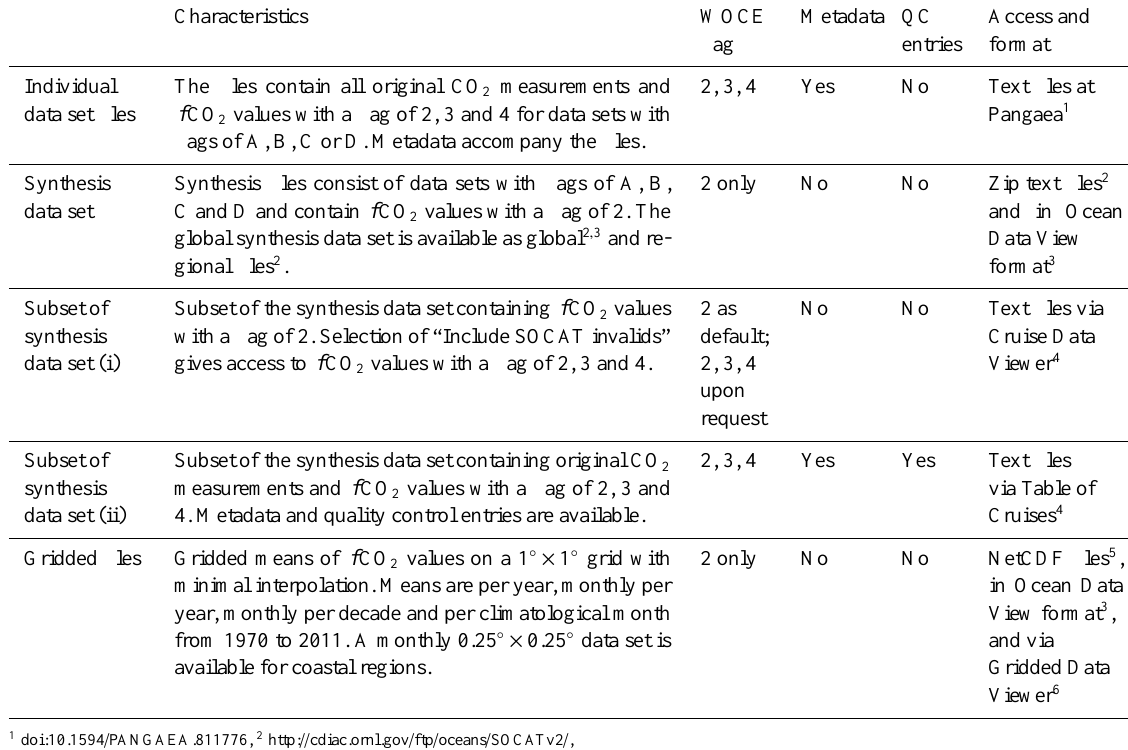
Table 2. Key characteristics of the three SOCAT data products for surface ocean f CO 2 values in version 2 (Sect. 2.4). The synthesis product is available as synthesis files and as subsets of the global synthesis data set. The table lists whether the data products include only f CO 2 data with a WOCE flag of 2 (good) or also with flags of 3 (questionable) and 4 (bad). Information on access to metadata and quality control comments is provided. All data products can be accessed via the SOCAT website (http: // www.socat.info) and via the links in the